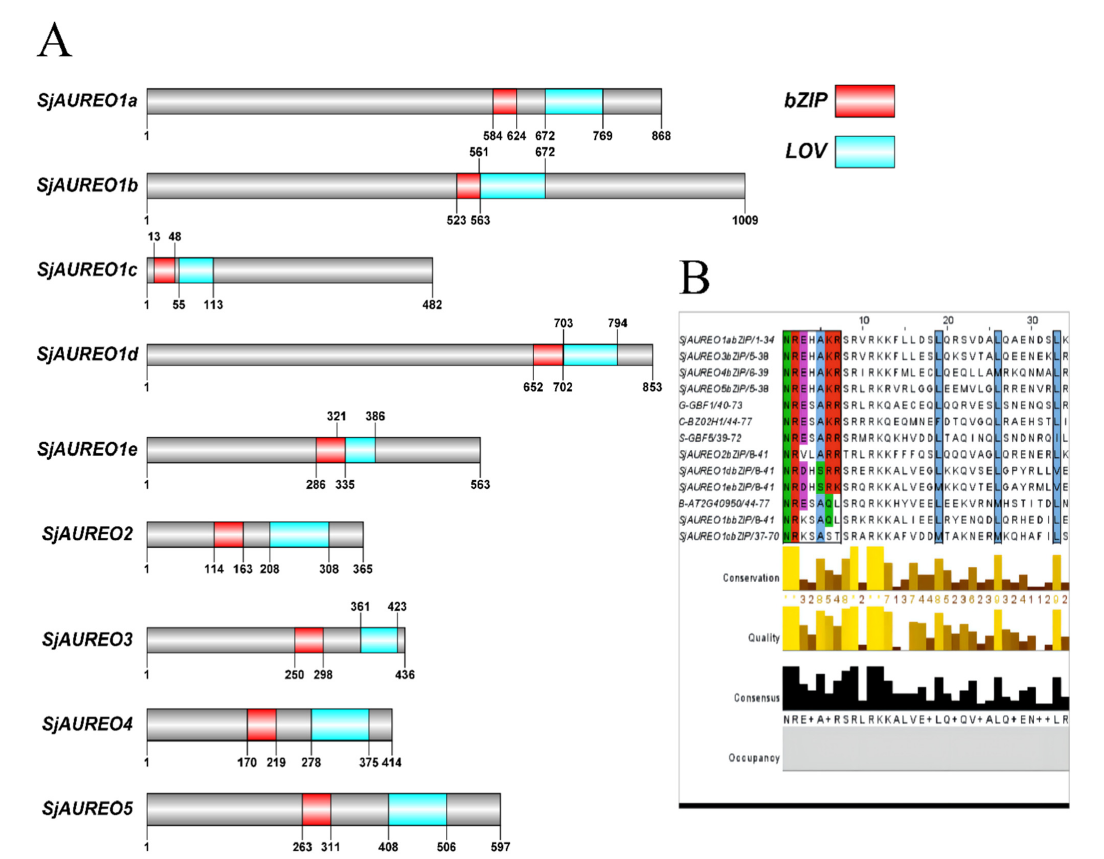
Figure 1. ( A ) Schematic diagram of bZIP and LOV domains in S. japonica AUREOs. ( B ) Comparison of the structural domain characteristics of Sj AUREO and Arabidopsis thaliana bZIP (AtBzip). According to the prediction results of pfam on the positions of the two domains of each AUREO gene, we have drawn the structural diagrams of nine Sj AUREOs. The length of the grey box represents the amino acid length of each Sj AUREO; red represents the bZIP domain; light blue represents the LOV domain. The exact position of each domain is given numerically in the figure. The thirty-four amino acids bZIP feature sequence fragment was intercepted in Figure 1B. Comparing Sj AUREOs with G-GBF, C-BZ02H, and S-GBF in AtbZIP (where G/C/S represents the bZIP grouping in the Arabidopsis study, followed by the name of the gene). The seven amino acids in the bZIP domain that can bind to DNA are marked with black boxes. The ZIP domain consists of heptad repeats of leucine (L) or related hydrophobic aa [40]. Located at the 19th, 26th, and 33rd amino acids, respectively. This simulation uses the default color for alignments in ClustalX. Different categories of amino acids are labeled separately with different types of colors. Each residue in the alignment is assigned a color if the amino acid profile of the alignment at that position meets some minimum criteria specific to the residue type. Conservation: conservation of total alignment less than 25% gaps; Quality: alignment quality based on blosum62 scores; Consensus: Characteristics of each repeat of AUREO; Occupancy: number of aligned